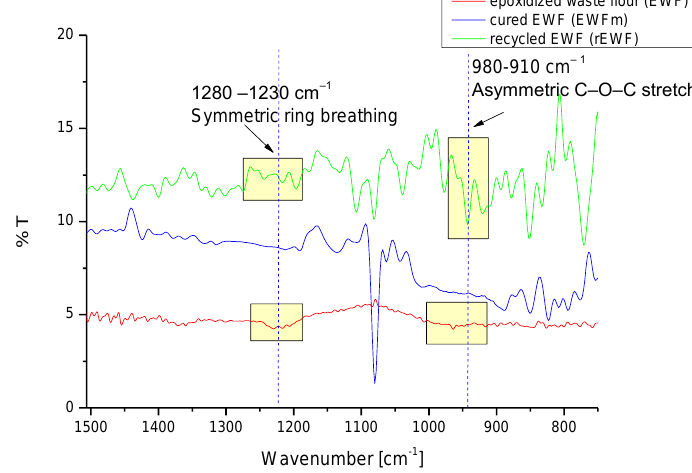
Figure 4. FTIR on EWF-based epoxy systems .